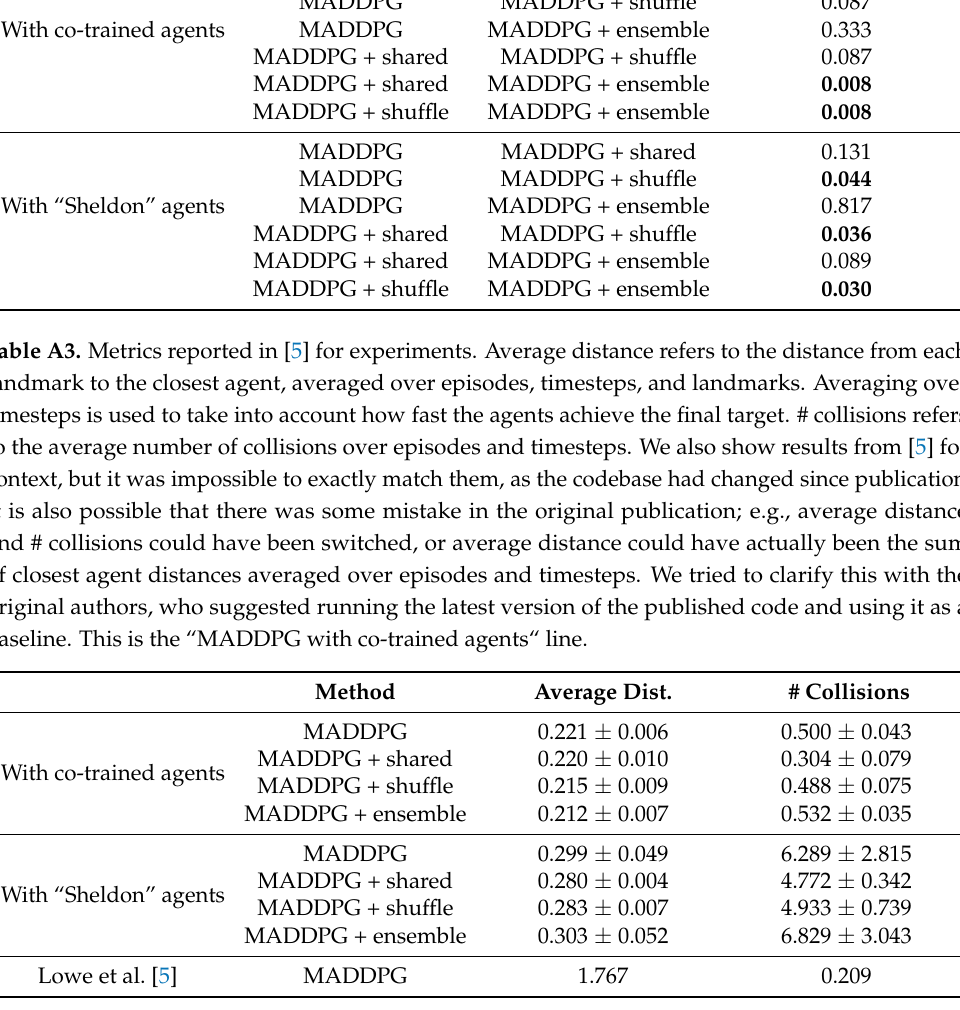
Table A2. Significance ( p -values) for means in Figure 5 calculated using a two-sided permutation test. Cases where the means are significantly different ( p -value < 0.05) are marked as bold. Notice that the results consist of 5 values in the case of co-trained agents and 45 in the case of “Sheldon” agents. Every single value was the fraction of episodes where all agents covered all landmarks out of 4000 evaluation episodes.